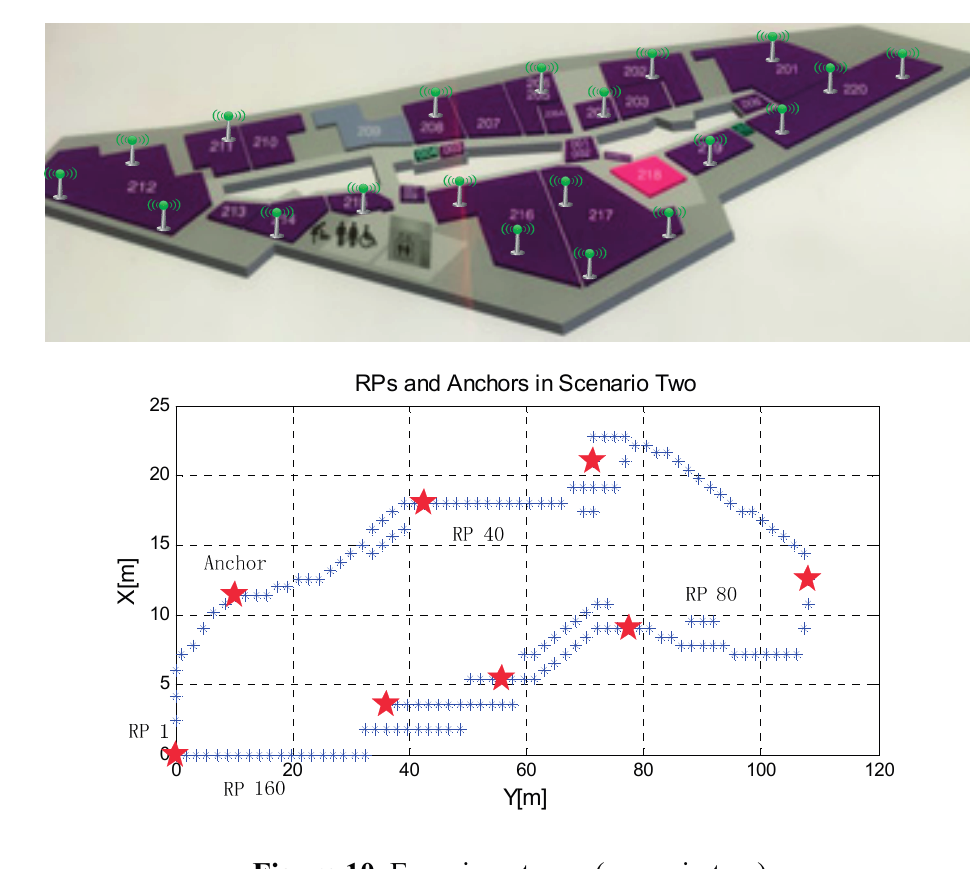
Figure 10. Experiment area (scenario